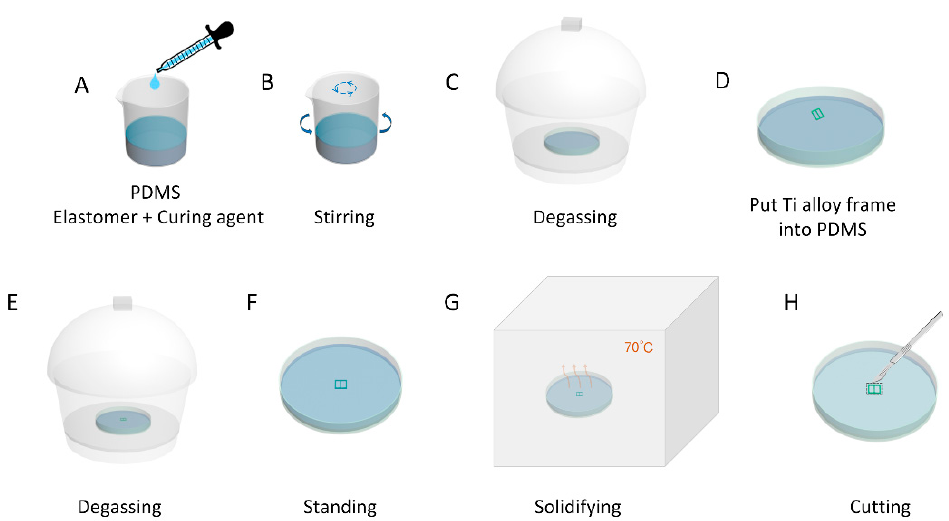
Figure 1. Schematic representation of the fabrication processes of a Ti-PDMS transparent cranial window device. ( A ) The PDMS base elastomer and curing agent were mixed in a ratio of 10:1. ( B ) The PDMS solution was stirred and degassed in a mixer. ( C ) The PDMS solution contained in the sterile cell culture dish was degassed in a vacuum desiccator. ( D ) Fully dried Ti frame was slowly put into the PDMS solution and completely immersed. ( E ) The PDMS solution containing the Ti frame in the sterile cell culture dish was degassed again in a vacuum desiccator. ( F ) The PDMS solution containing the Ti frame in the sterile cell culture dish was placed on the optical platform to stand still. ( G ) The PDMS solution containing the Ti frame in the sterile cell culture dish was solidified in a convection oven incubator. ( H ) Ti-PDMS cranial window device was disconnected from the PDMS matrix along the outer edge with a scalpel.